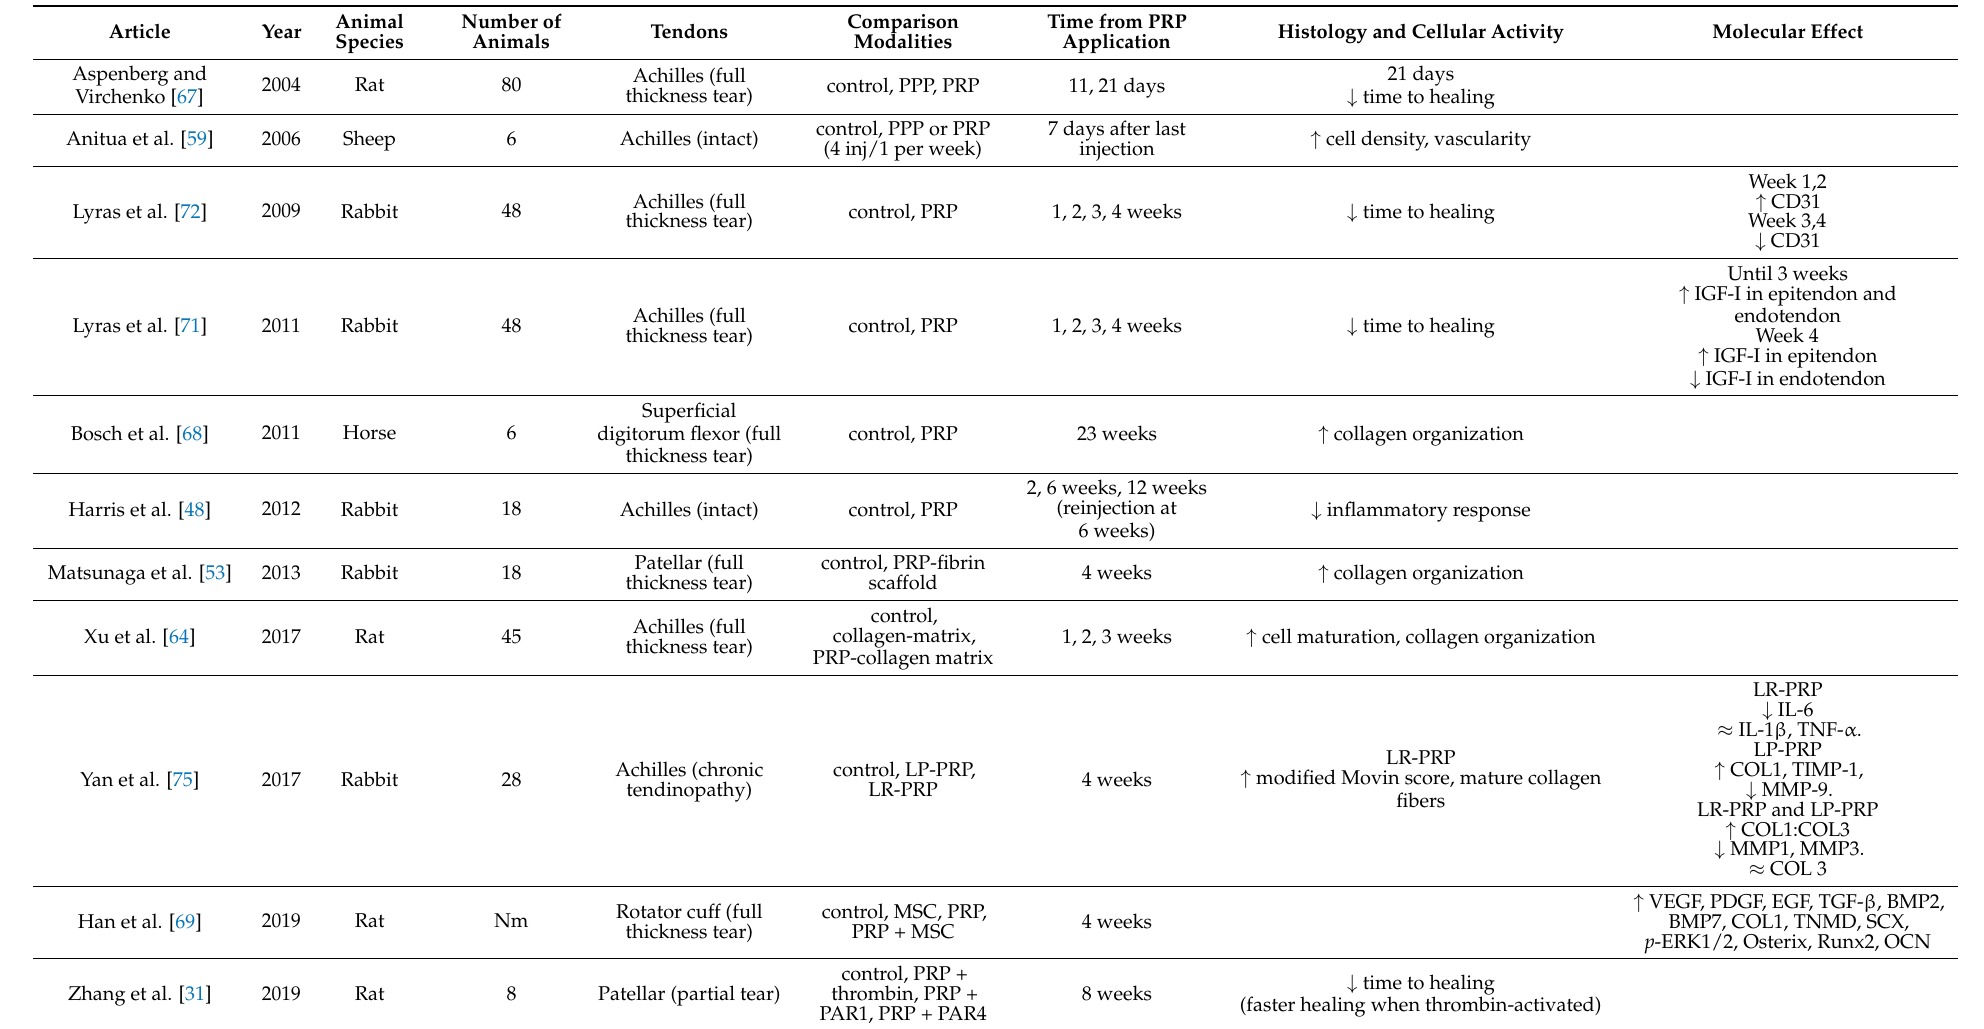
Table 4. Histological and molecular effect of PRP on tendons in in vivo animal